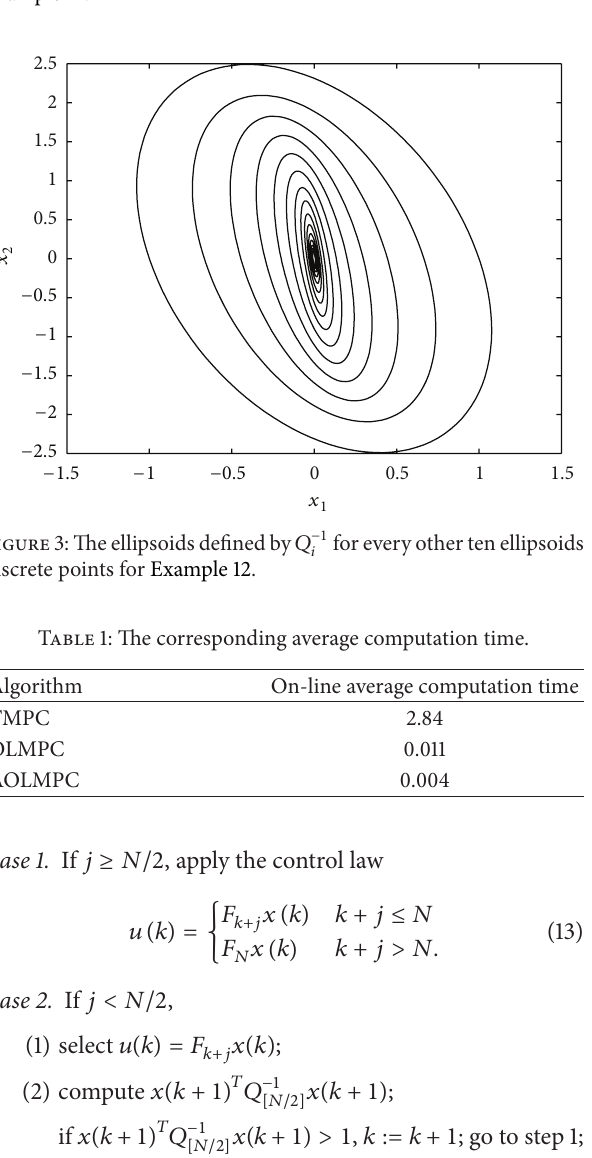
Figure 2: The ellipsoids defined by 𝑄 −1 𝑖 for all 150 discrete points for Example 12.